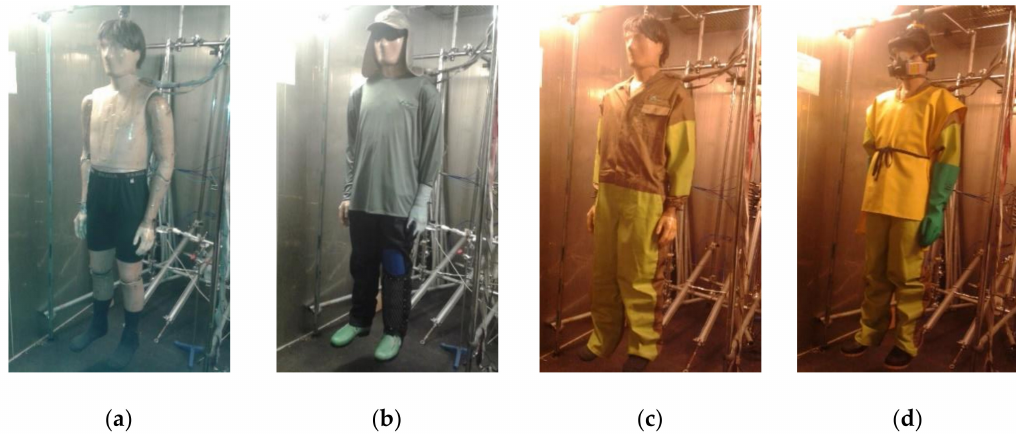
Figure 1. Tested clothing: ( a ) underwear for both systems (provided by the laboratory), ( b ) sugarcane harvester’s outfit (glove only on one hand and leg protector on one leg), ( c ) chemical sprayer’s protective coveralls on top of underwear and ( d ) chemical sprayer’s complete outfit with outer protective